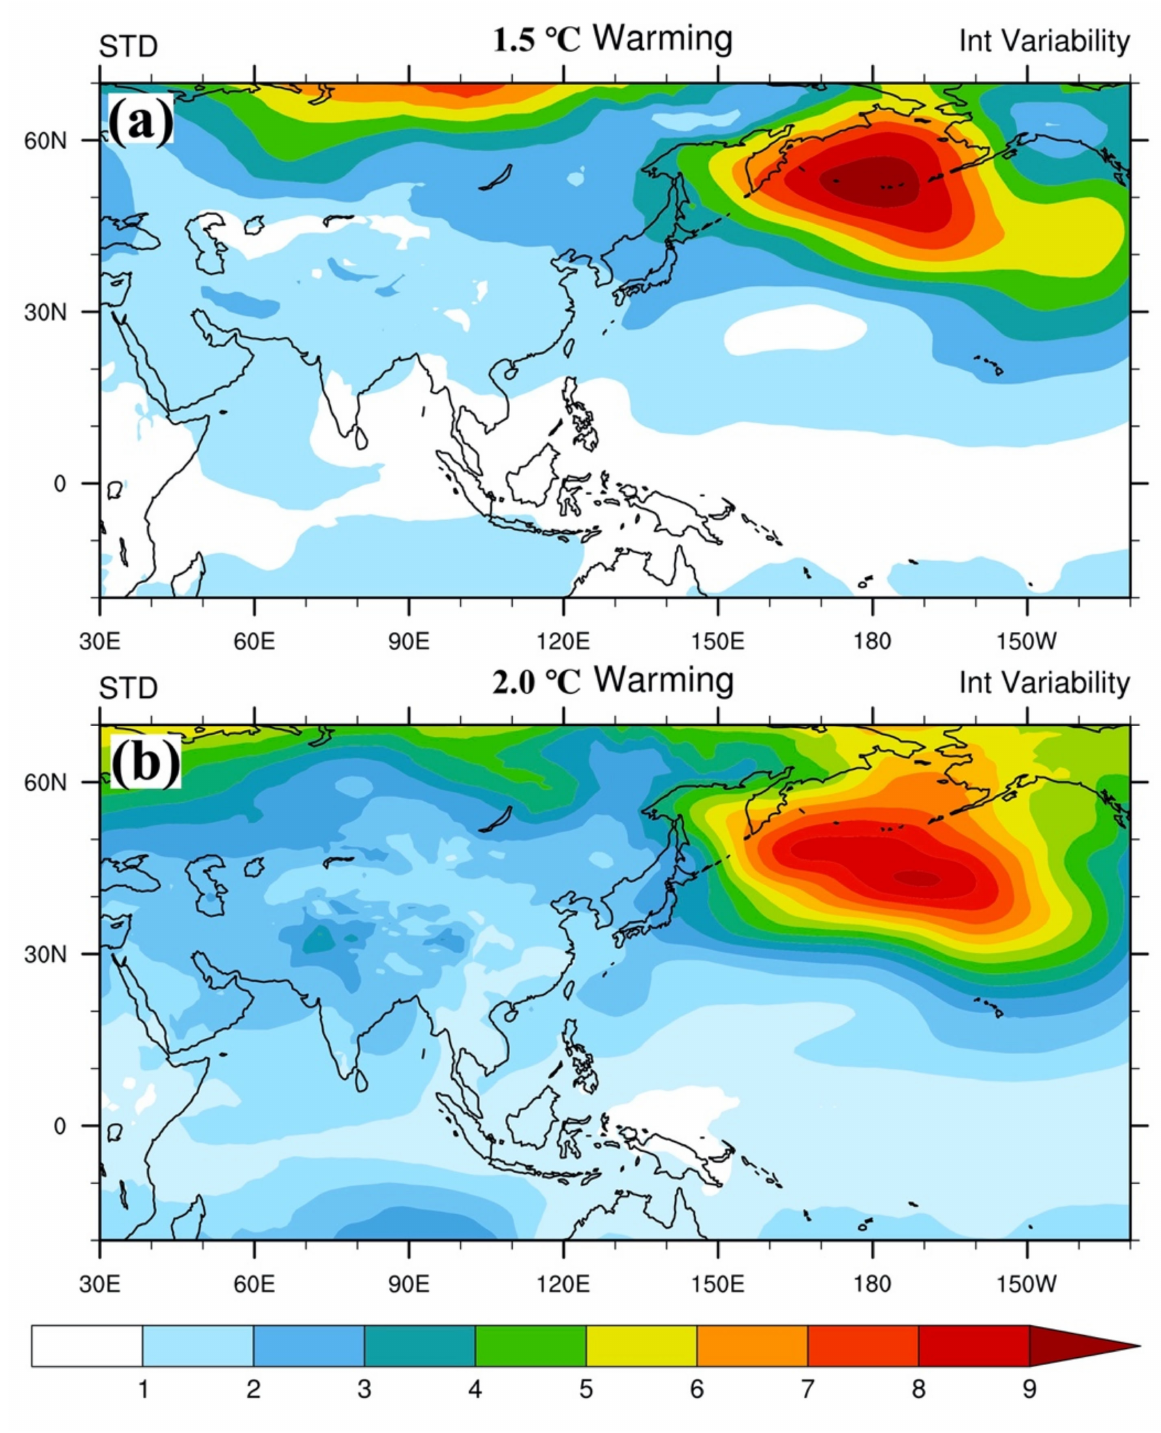
Figure 5. Internal climate variability of SLP (hPa/year) under ( a ) 1.5 ◦ C ( b ) 2.0 ◦ C scenarios. The high-pressure center over the SCS under the 2.0 ◦ C warming strengthens the SCS anticyclone, which in turn strengthens the low level (850 hPa) monsoon wind from the western Pacific Ocean/SCS (near the Philippines) to the eastern Indian Ocean. A cross basin strengthening of easterly wind vectors from the western Pacific Ocean/SCS to the equatorial Indian Ocean strengthens the transport of Pacific origin moisture to the Indian subcontinent. In Figure 1, under the 2.0 ◦ C warming scenario, we observe a decreasing trend in precipitation on and around the SCS anticyclone, while the precipitation is projected